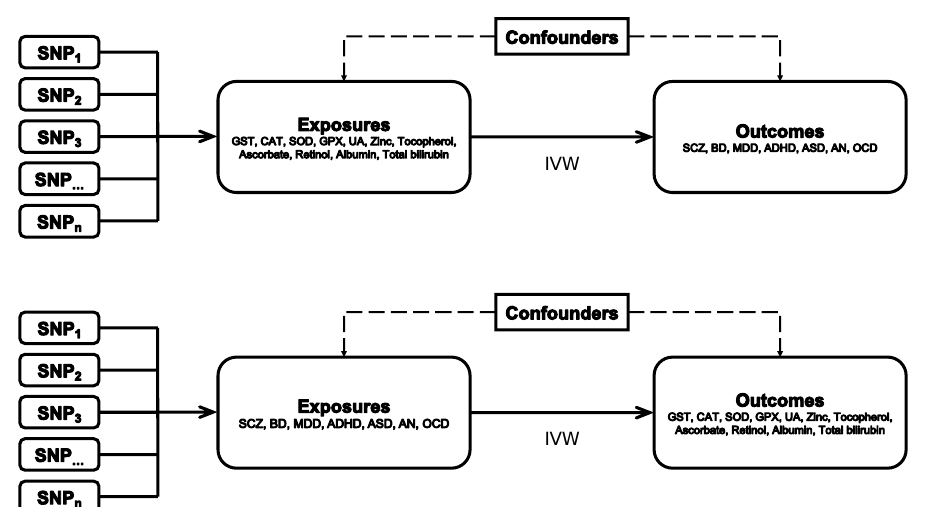
Figure 1. Flow chart of the bidirectional MR study design. GST, glutathione S-transferase; CAT, catalase; SOD, superoxide dismutase; GPX, glutathione peroxidase; UA, uric acid; SCZ, schizophrenia; BD, bipolar disorder; MDD, major depressive disorder; ADHD, attention-deficit/hyperactivity disorder; ASD, autism spectrum disorder; OCD, obsessive-compulsive disorder; AN, anorexia nervosa; IVW, inverse variance weighted method; SNP, single nucleotide polymorphism.